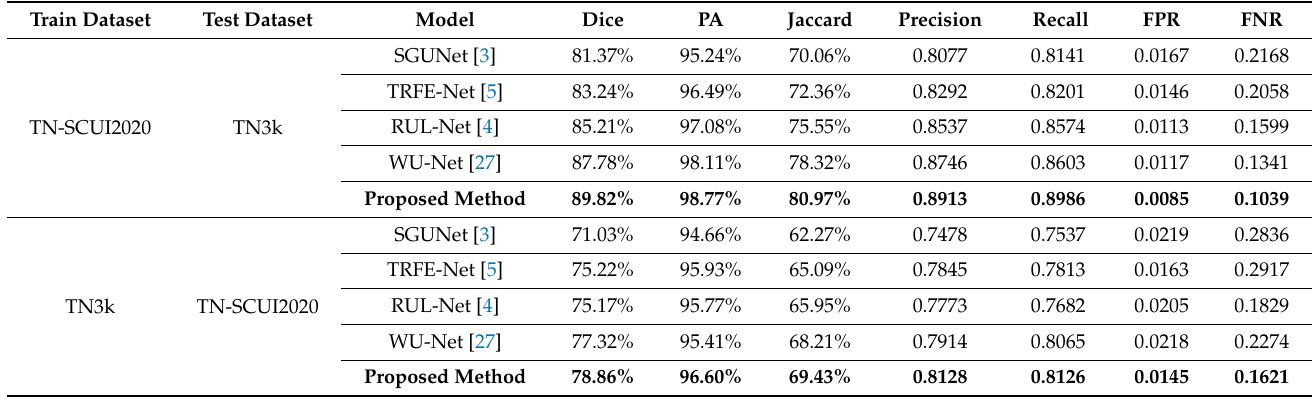
Figure 9. Qualitative comparison of different models on the TN3k dataset. Table 2. Comparison of the results of state-of-the-art thyroid nodule segmentation models of general- ization